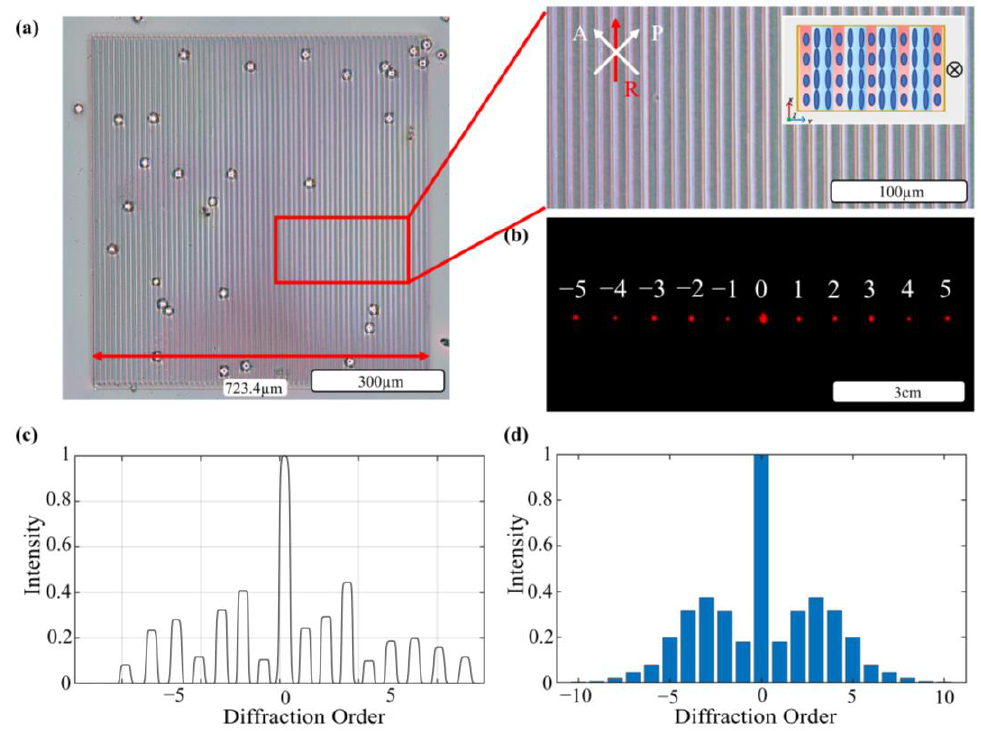
Figure 6. Characteristics of a laser-written diffraction grating in a free-standing LC film. ( a ) Polarizing optical microscope (POM) and ( b ) replay field images after delamination of the film. The white arrows labelled P and A refer to the orientations of the polarizer and analyzer, respectively, and the red arrow labelled R represents the rubbing direction of the alignment layers in the glass cell. ( c ) Experimental results of the intensity profile for the different diffraction orders. The results have been normalized to the value of the intensity of the zeroth order. ( d ) Simulated normalized intensity distribution for the free-standing film in the replay field after delamination.